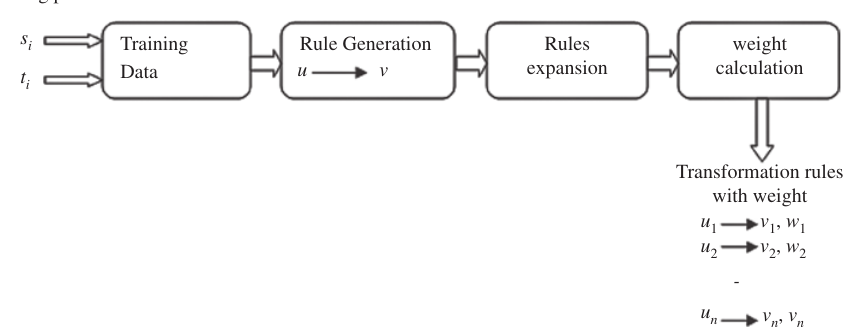
Figure 2: Rule Generation